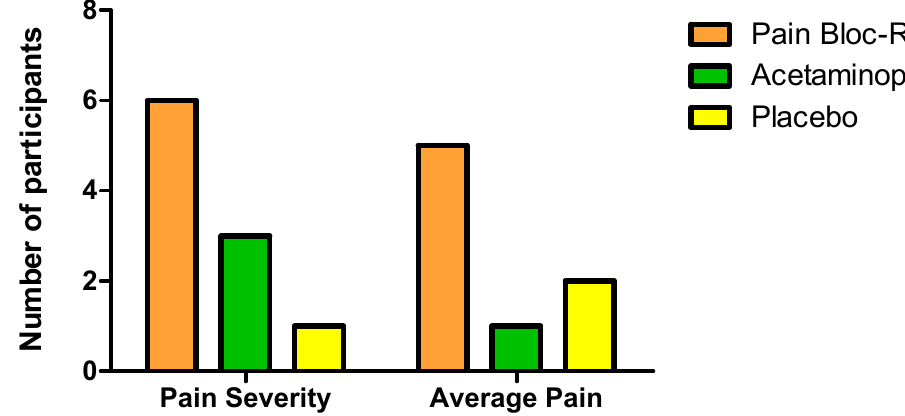
Figure 3. Number of participants reaching a minimal clinically important improvement based on the BPI pain severity scores (at least 32.3%) and average pain scores (at least 27.7%) in the per protocol (PP) population. Table 4. The BPI pain severity score and change in pain severity score from pre-supplementation to day 7 in the PP population ( n =